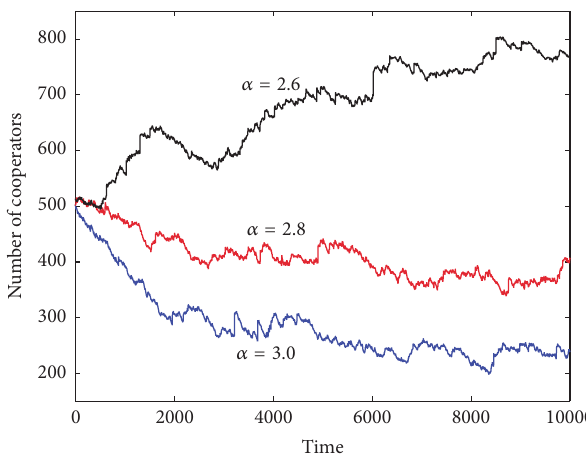
Figure 3: A single sample run of Monte Carlo simulation: the number of cooperators is initially half of the 1,000 population and soon decreases through a series of conflicts which is power law distributed in size with 𝛼 = 3 .